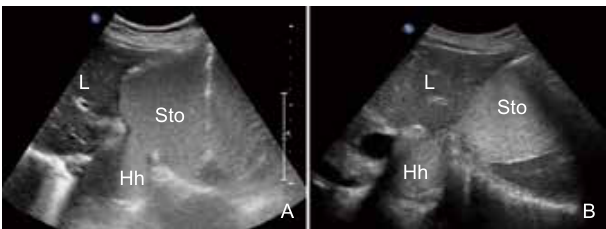
Figure 8 Esophageal hiatus hernia. (A) Contrast ultrasound imaging shown the dilation of cardia; (B) Oral contrast agent fills the